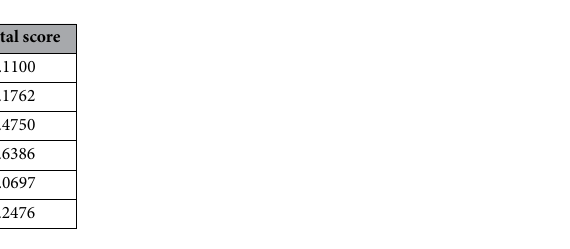
Table 1. Protein crystal information and the score of the best binding